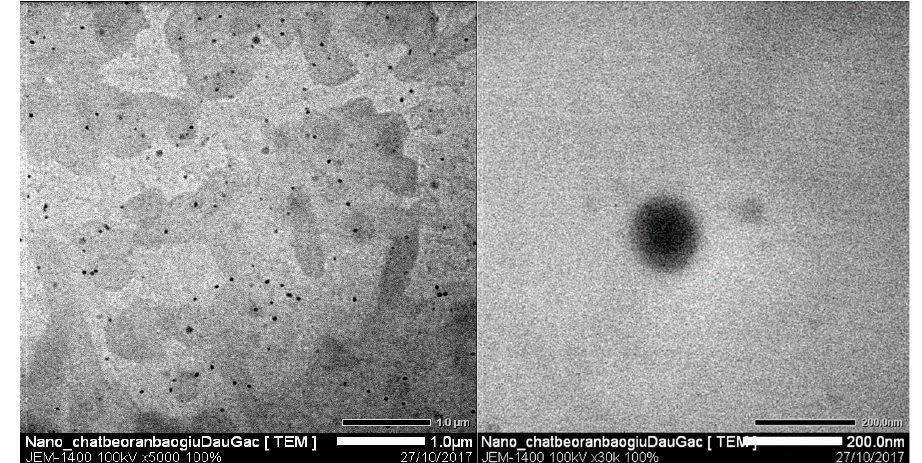
Figure 7. Transmission electron microscopy (TEM) images of gac oil-loaded SLNs.